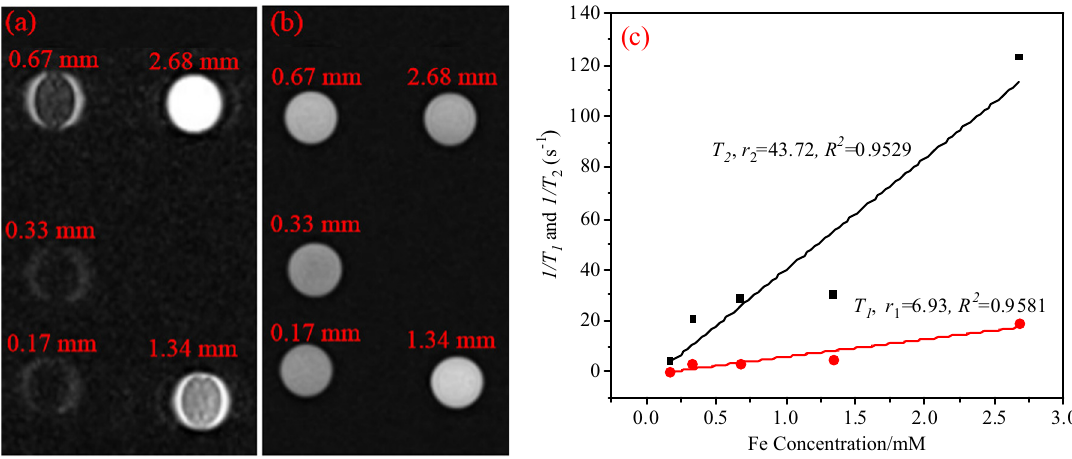
Figure 7: T 1 and T 2 mapping images of di ff erent concentrations of Fe 3 O 4 @DDT - PMAA MF in vitro , ( a ) T 1 mapping images, ( b ) T 2 mapping images, and ( c ) T 1 longitudinal and T 2 transverse relaxivity with di ff erent Fe